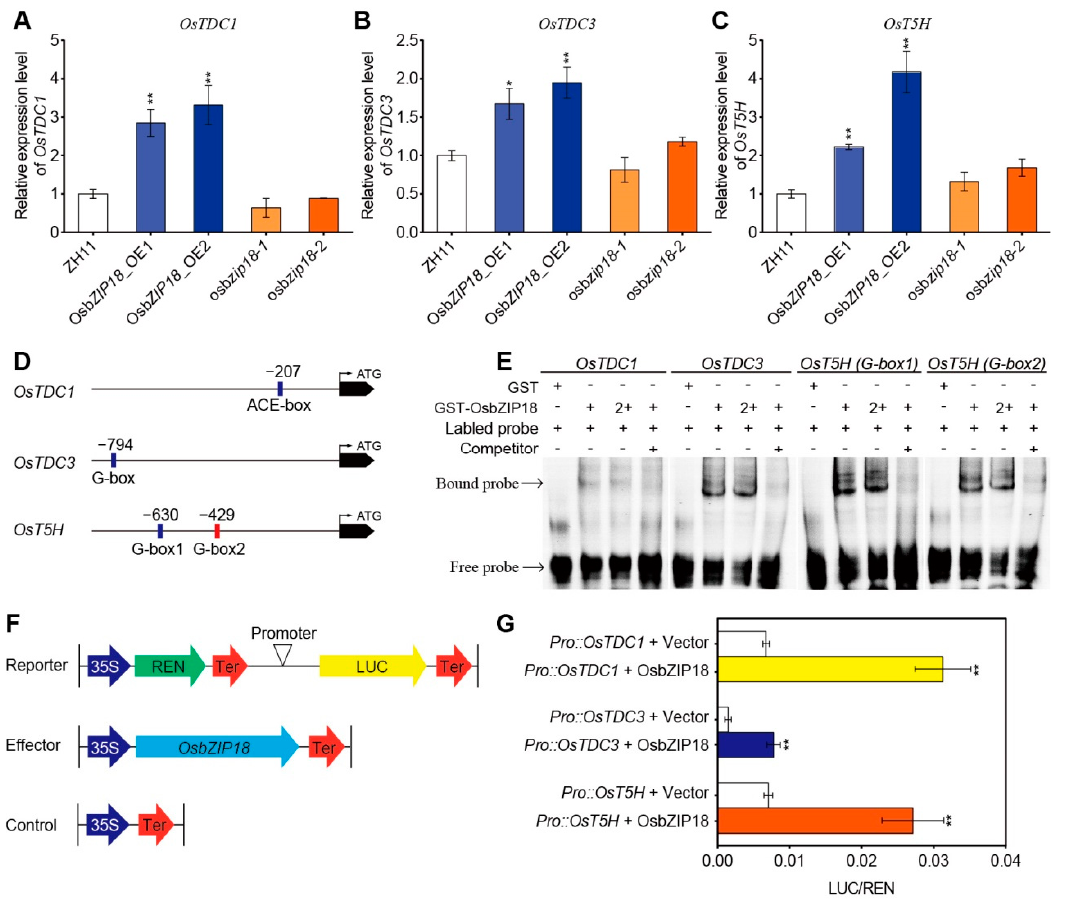
Figure 4. OsbZIP18 directly binds to the ACE/G-box cis -elements of serotonin biosynthesis genes and positively regulates their expression. ( A – C ) The expression level of serotonin biosynthesis genes OsTDC1 ( A ), OsTDC3 ( B ), and OsT5H ( C ) in the leaves of the indicated plants. The relative expression levels were normalized to those of ubiquitin . All plants were grown in a paddy field. ( D ) Diagram of the OsTDC1 , OsTDC3, and OsT5H promoter regions, showing the relative positions of the ACE/G-box cis -elements (blue and green rectangles). ( E ) Electrophoretic mobility shift assay (EMSA) assay, showing the OsbZIP18 recombinant proteins bound to the ACE/G-box cis -elements in the OsTDC1 , OsTDC3, and OsT5H promoters. ( F ) Schematic diagram of the effector and reporter plasmids used in the transient assay in leaf epidermal cells of N. benthamiana . Ren, Renilla luciferase; LUC, firefly luciferase. ( G ) OsbZIP18 activates the transcription of OsTDC1 , OsTDC3 , and OsT5H . N. benthamiana leaves were infiltrated with different combinations of effectors and reporters. The LUC activity was normalized to the REN activity as an internal control. The p -value was calculated using Tukey’s test, n = 3. * p < 0.05 and ** p <